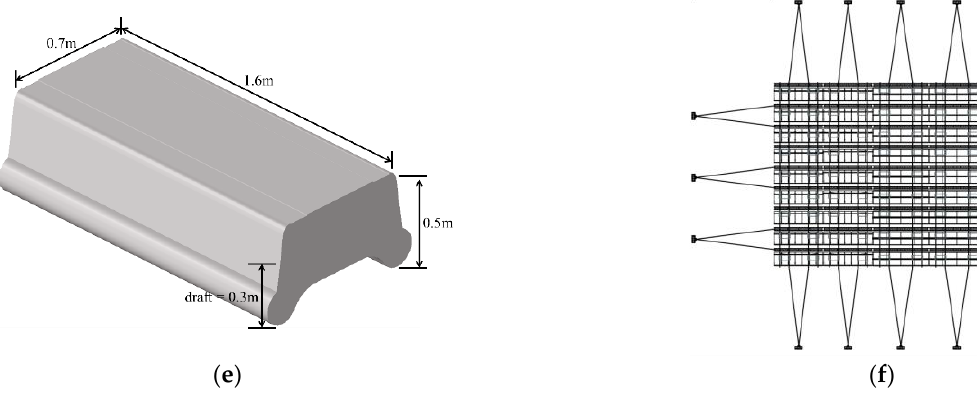
Figure 2. Configuration of the floating PV platform composed of 12 floating units: ( a ) Sketch of a plan view of overall PV power plant; ( b ) PV arrangement; ( c ) Sections of FRP and POS frames; ( d ) Frame structure of a shed-type floater unit; ( e ) Buoy; ( f ) Mooring arrangement.